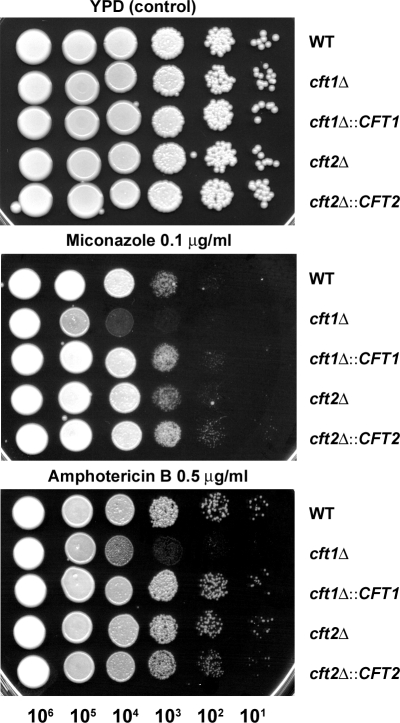
Deletion of CFT1 Increases Susceptibility to Antifungal Agents that Target Fungal Sterol Biosynthesis and FunctionThe growth of strains in media containing the antifungal drugs miconazole and amphotericin B was monitored to assess sensitivity. Ten-fold serial dilutions of cells (starting at 106 cells) were spotted onto YPD plates with and without the antifungal drug indicated. Plates were incubated at 30°C for two days.